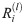
Left: A neural network-shaped classifier during prediction time.
w
ij are connection weights. a
i is the activation of neuron i. Right: The neural network-shaped classifier during layer-wise relevance computation time. Ri(l) is the relevance of neuron i which is to be computed. In order to facilitate the computation of Ri(l) we introduce messages Ri←j(l,l+1). Ri←j(l,l+1) are messages which need to be computed such that the layer-wise relevance in Eq (2) is conserved. The messages are sent from a neuron i to its input neurons j via the connections used for classification, e.g. 2 is an input neuron for neurons 4, 5, 6. Neuron 3 is an input neuron for 5, 6. Neurons 4, 5, 6 are the input for neuron 7.